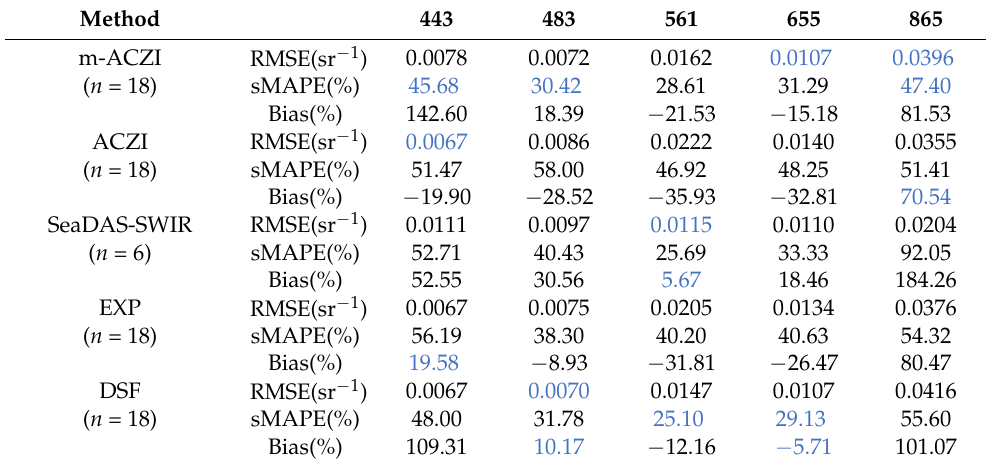
Table 4. Statistics of the accuracy measures for atmospheric correction algorithms for floating bloom using in situ R rs measurements. The BLUE number represents the minimal statistical